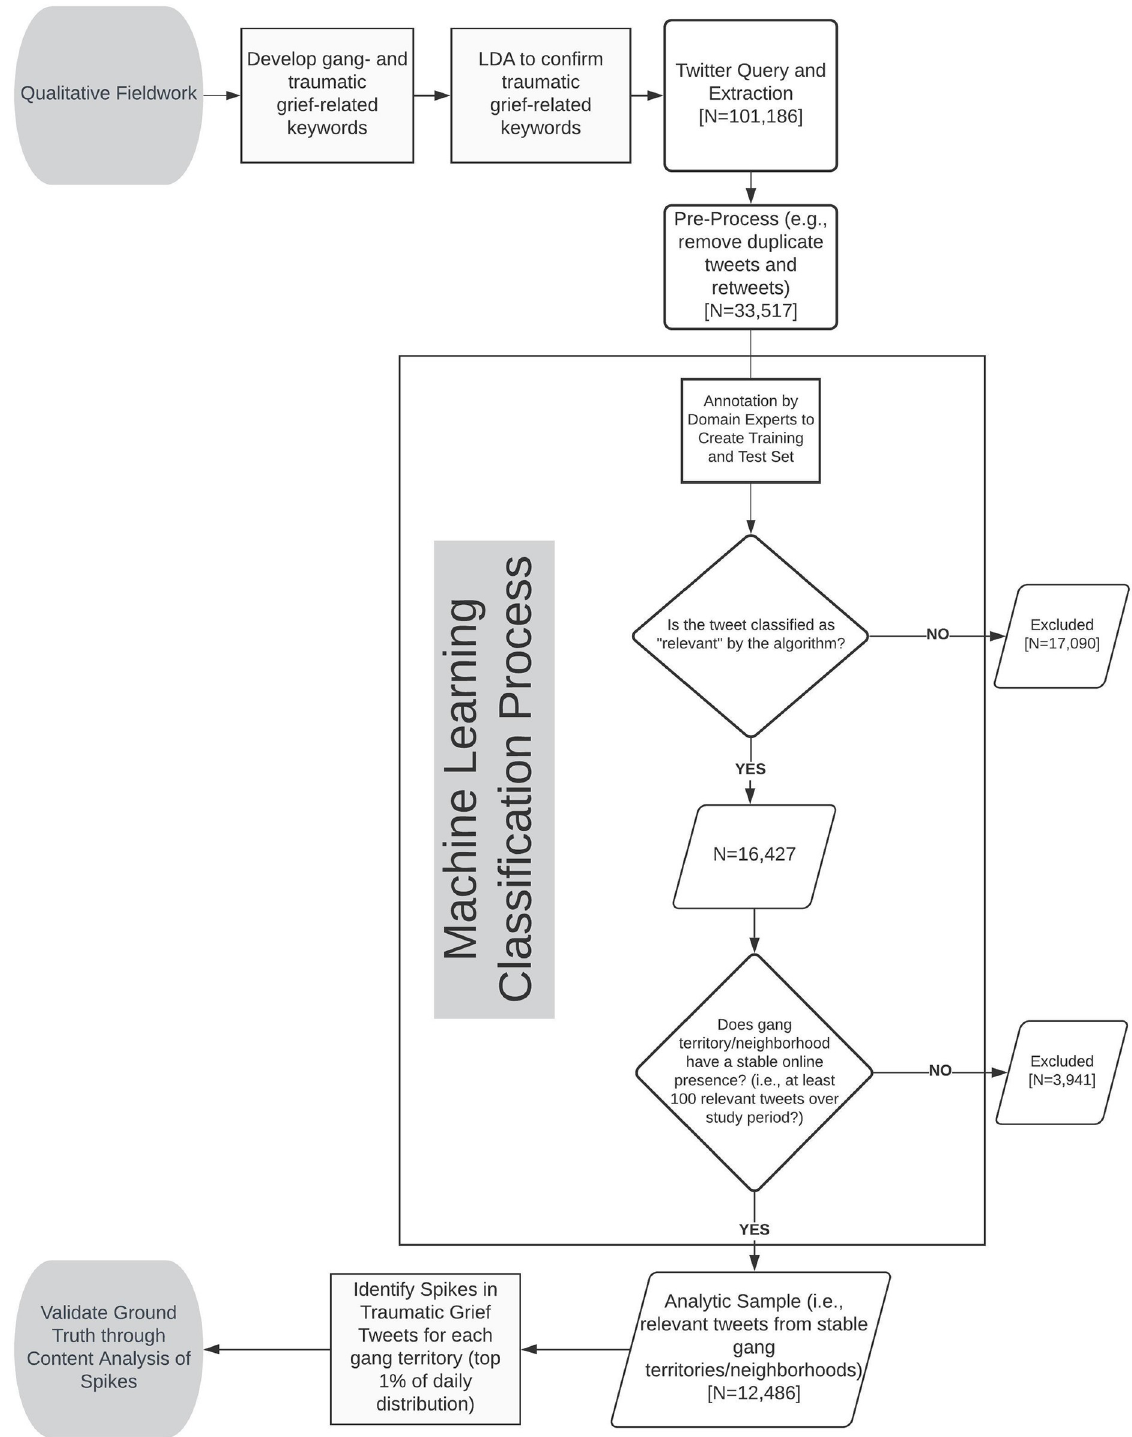
Fig 1. Workflow for qualitative fieldwork, machine learning classification, and content analysis.